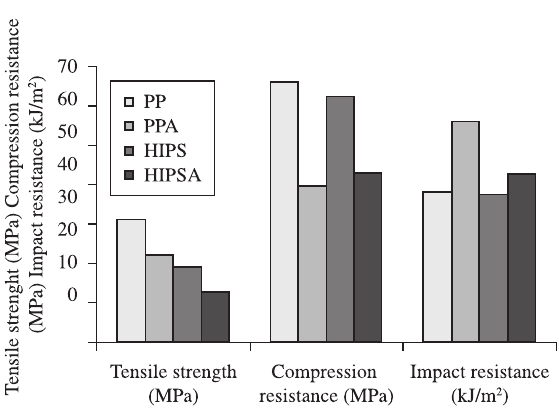
Figure 5. Comparison of mechanical trial results: polypropylene (PP), polystyrene (HIPS), polypropylene/açaí fiber composite (PPA) and polystyrene/açaí fiber composite